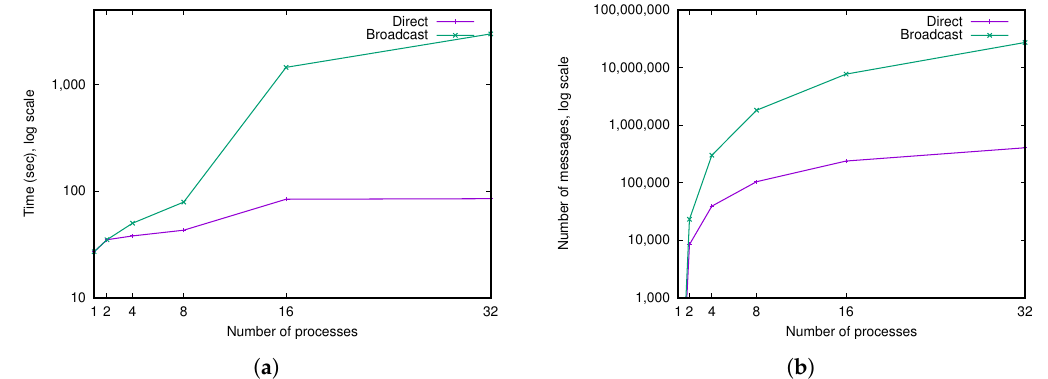
Figure 10. Comparison of two possible communication methods, for increasing number of processes (from 1 to 32). “Direct”: messages are sent directly to concerned blocks; “Broadcast”: messages are sent to all processes. ( a ) Total computation time, in seconds, average for the six meshes. ( b ) Number of messages exchanged, average for the six meshes.